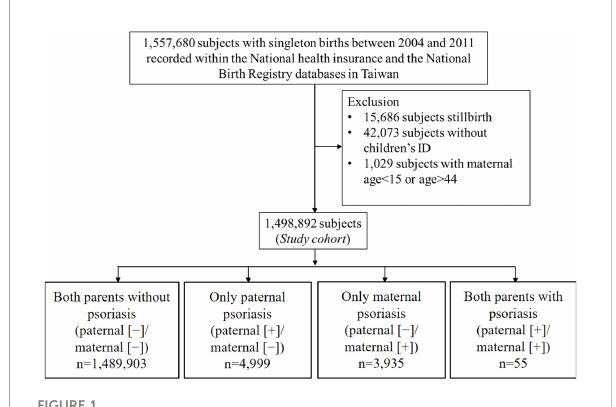
FIGURE 1 Flowchart of the population-based retrospective cohort